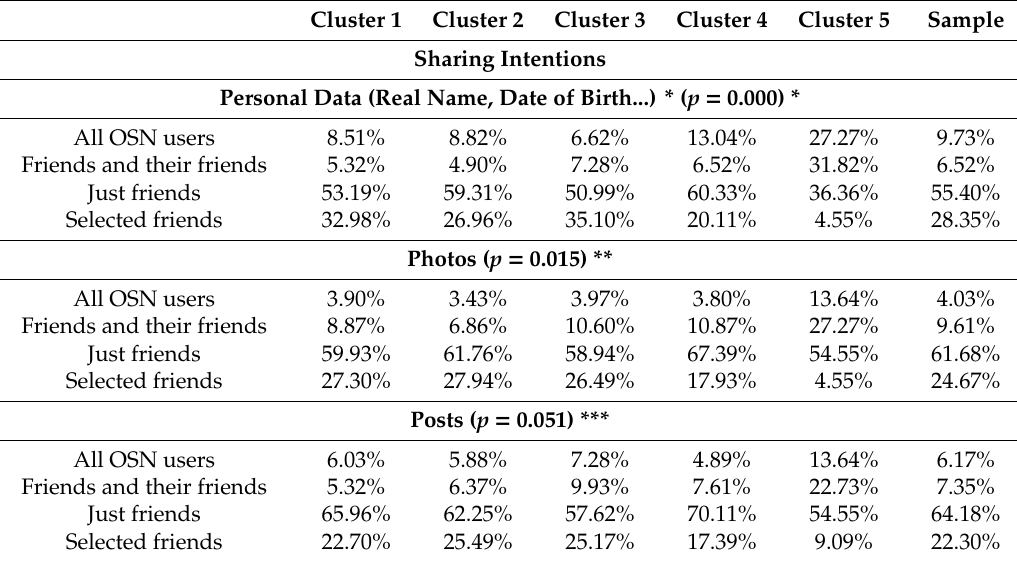
Table A2. Self-reported privacy related behavior across